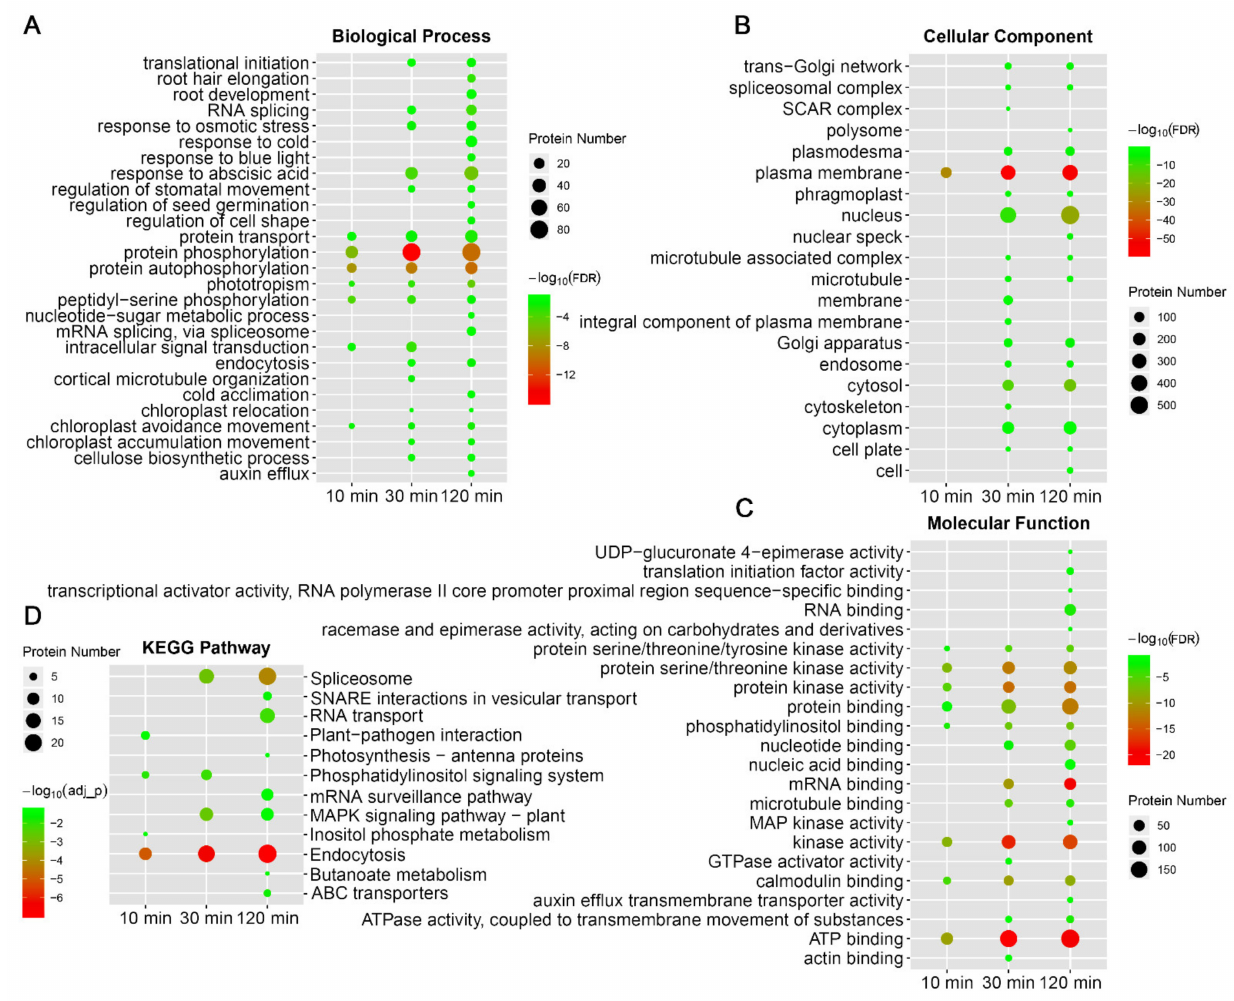
Figure 4. GO enrichment ( A – C ) and KEGG pathway ( D ) analysis of proteins with phosphopeptides significantly responsive to different time points of cold